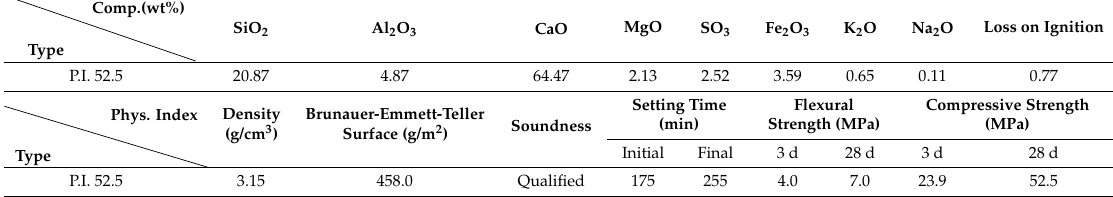
Table 1. The main mineral ingredients and physical index of cement.